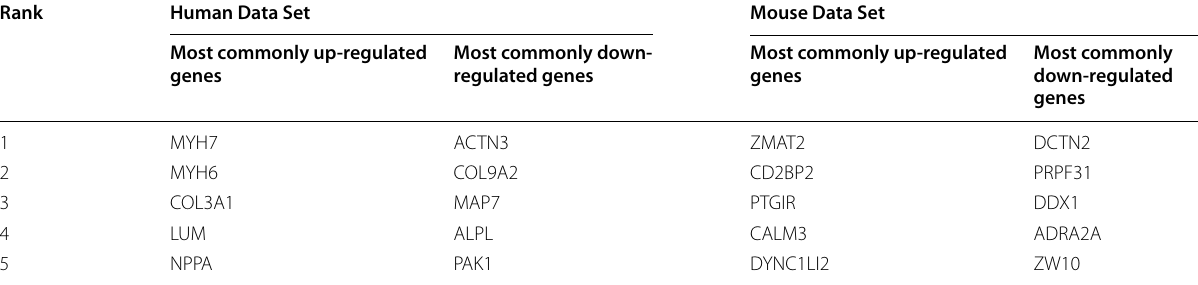
Table 6 Top 5 most commonly up- and down-regulated genes for data sets Rank Human Data Set Mouse Data